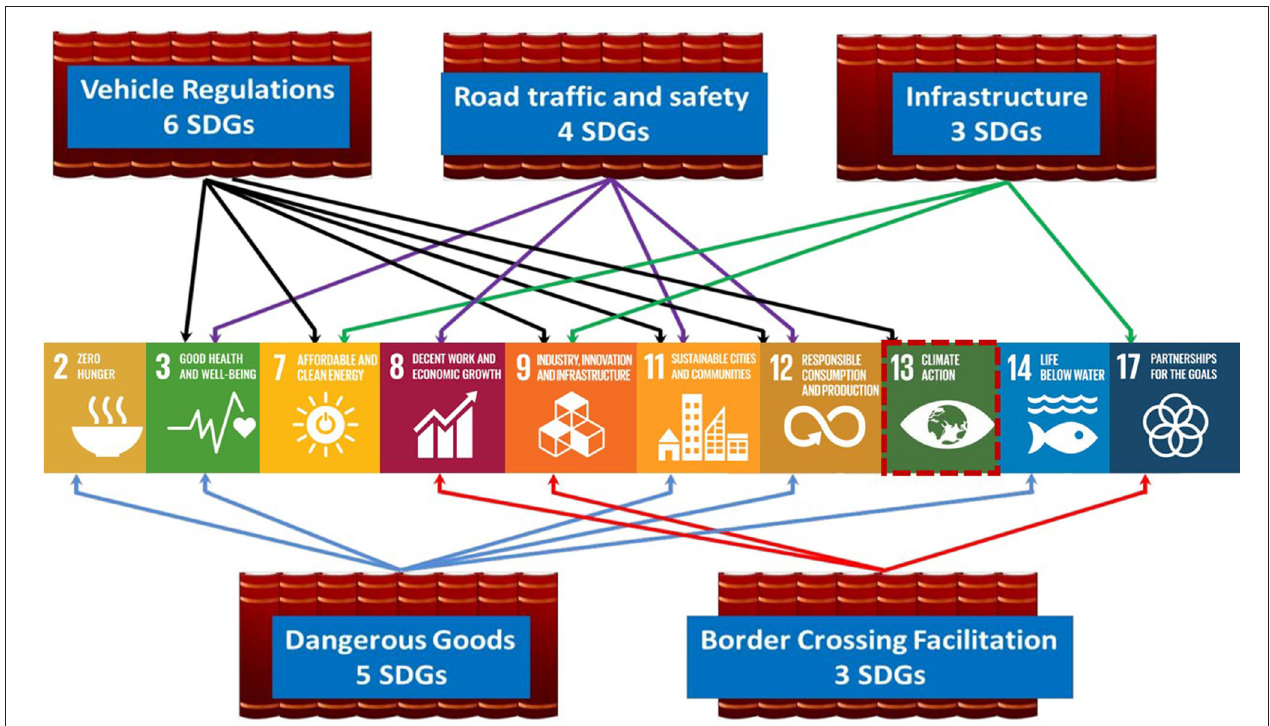
FIGURE 1 | Linkage between transport sector and the UNs’ Sustainable Development Goals (United Nations (UN),